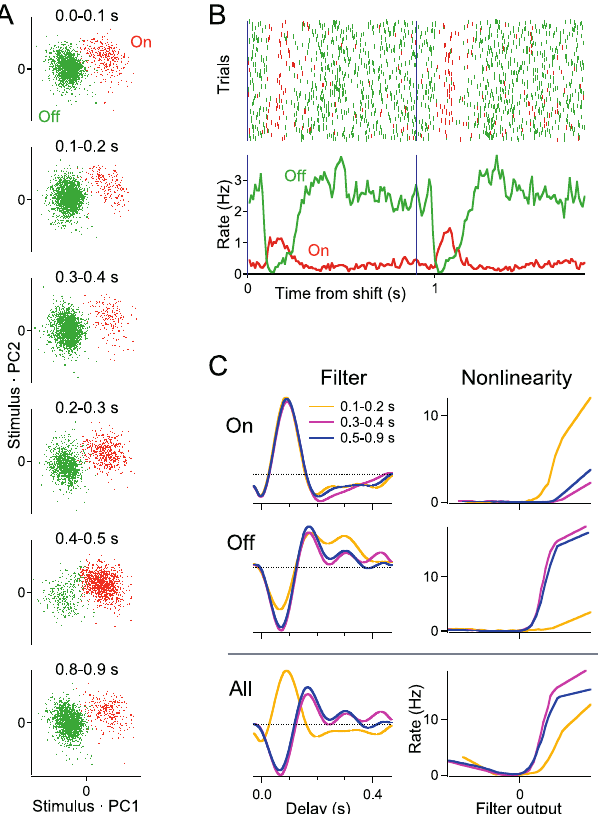
Figure 5. A Peripheral Shift Modulates On and Off Pathways in Opposite Directions (A) The spike-triggered stimuli of a sample ganglion cell, projected onto the first two principal components (PC1 and PC2), as in Figure 4B. Each plot uses spikes from a different time interval relative to the peripheral shift. In all cases, one finds two clusters of stimulus waveforms: one On- type and one Off-type. (B) A raster graph of this cell’s firing, displayed as in Figure 1D, but with On spikes and Off spikes indicated separately. Bottom: average firing rate derived from the On and Off pathways. (C) Top: the 2LN model derived from spikes in three different time intervals: 0.1–0.2 s, 0.3–0.4 s, and 0.5–0.9 s. Linear filter and nonlinearity were computed separately from the On spikes and Off spikes as identified by the cluster plot (Figure 5A). Bottom: the single-pathway LN model computed from all spikes. Note the U-shaped nonlinearity to account for both On and Off spikes, as well as the polarity reversal of the filter shortly after the shift.